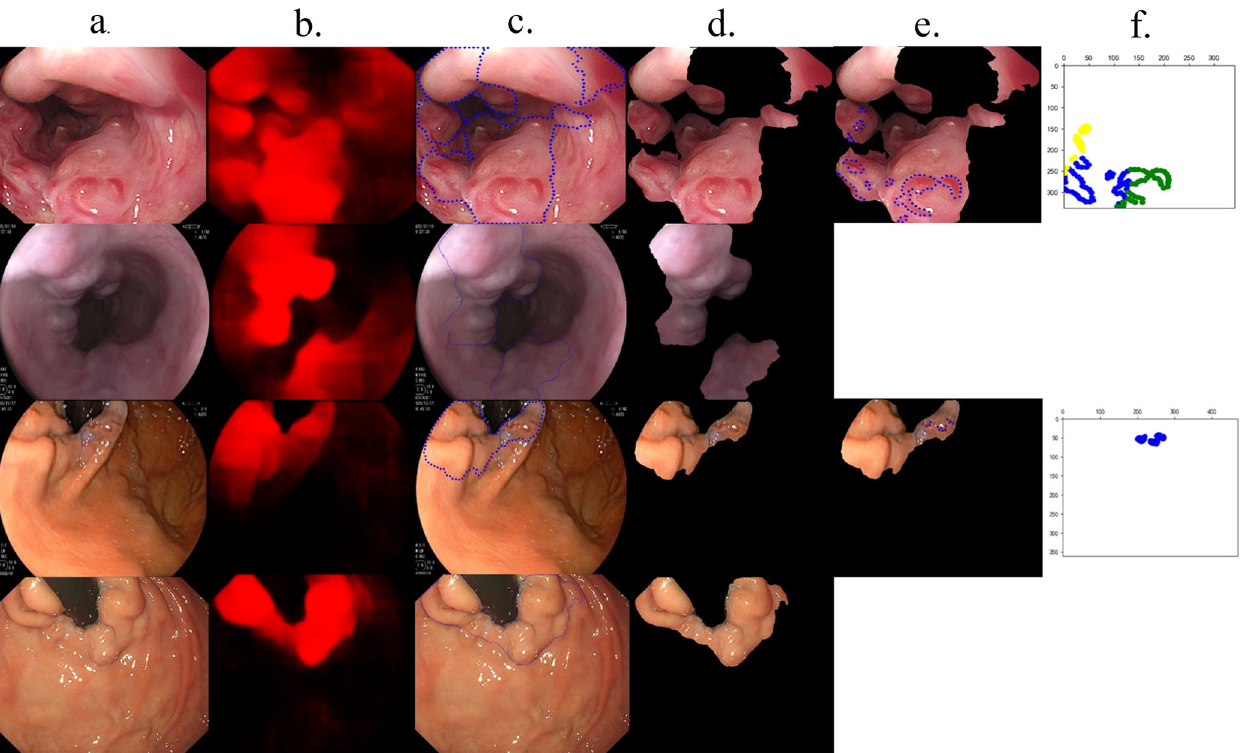
Fig. 2 Representative images of how the system processes images. a The fi rst column shows the original endoscopic images. b The second column shows model 1 (EV segmentation) and model 5 (GV segmentation) generate a probability map (heat map) for each image internally. The brighter the color in the image, the higher the likelihood the region is varices. A cut-off value of 0.4 was chosen to delineate the regions of GEV. c The delineation of varices on the endoscopic images is shown in this column. d Nonvariceal regions were deleted in this column. e RC were delineated on the varices in this column. A cut-off value of 0.5 was chosen to delineate RC. f Density-based spatial clustering of applications with noise model divides the red color signs into different groups, and groups were represented as different